Question: What type of chart is this?
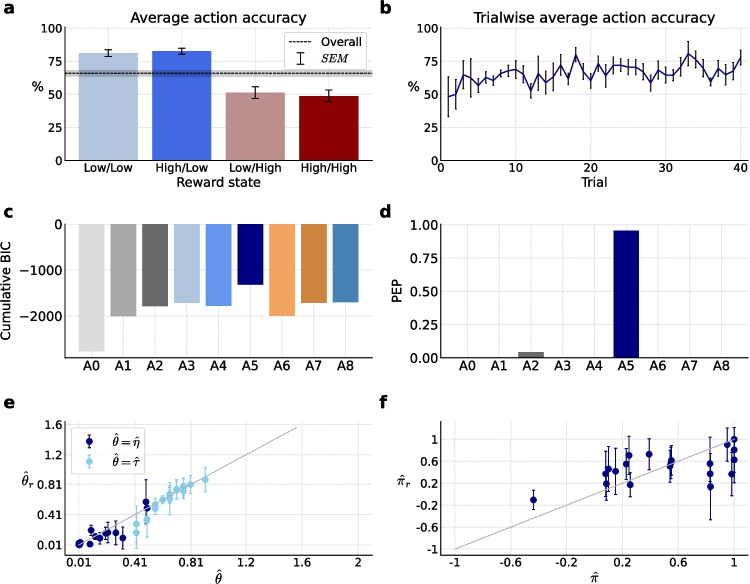
Answer: bar